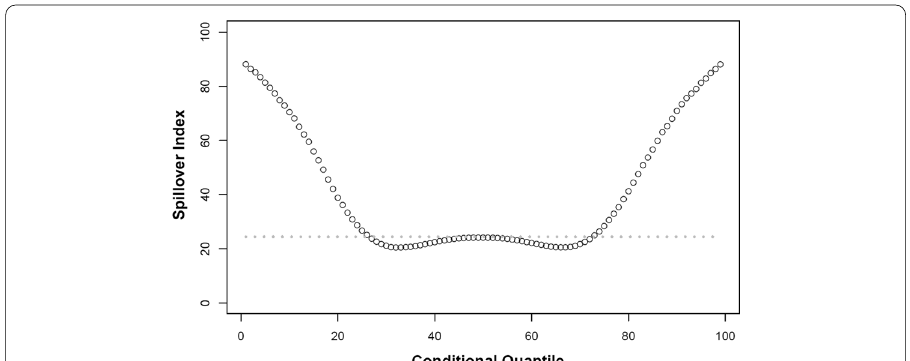
Fig. 5 Variation in the DY spillover index over the conditional distribution. Notes: This figure shows the values of the spillover index defined in (6) evaluated at the τ th conditional quantile (plotted as a circle) relative to the value at the conditional mean (shown by the dashed